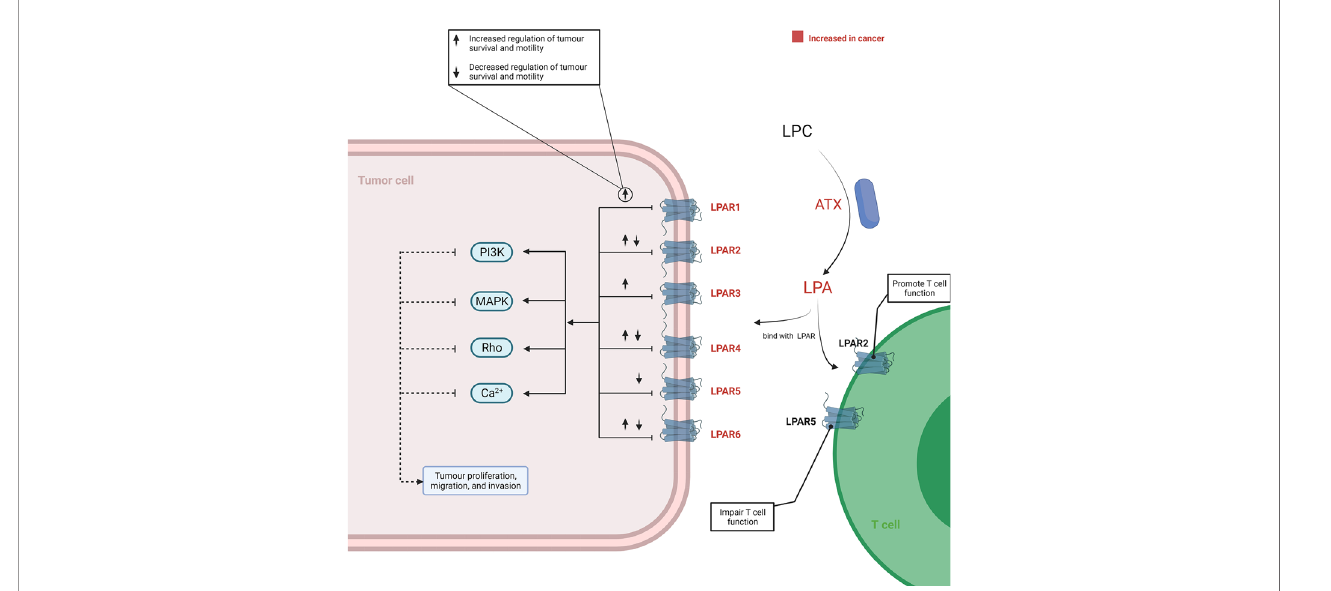
FIGURE 3 | Overview of theLPC/ATX/LPA signalling axisin cancer.LPA isproduced via ATX-mediated hydrolysisof LPC. LPA-LPAR signalling ismagni fi ed andutilised by cancer cellsto supporttheirgrowth and metastasisthrough increasing thelevel ATX and LPAR withinthe TME. When LPA binds with LPAR1-6, itcan generate various effects on cancer cells. This process involves theinduction of several signallingcascades, including PI3K, MAPK,Rho, andCa2+ mobilisation-related signalling. T cellsunder the TME can also bepromoted or impaired through binding with different LPARs byLPA. The fi gure was created with BioRender.com. ATX,autotaxin; LPA, lysophosphatidic acid; LPAR,LPA receptors; LPC,lysophosphatidylcholine; TME,